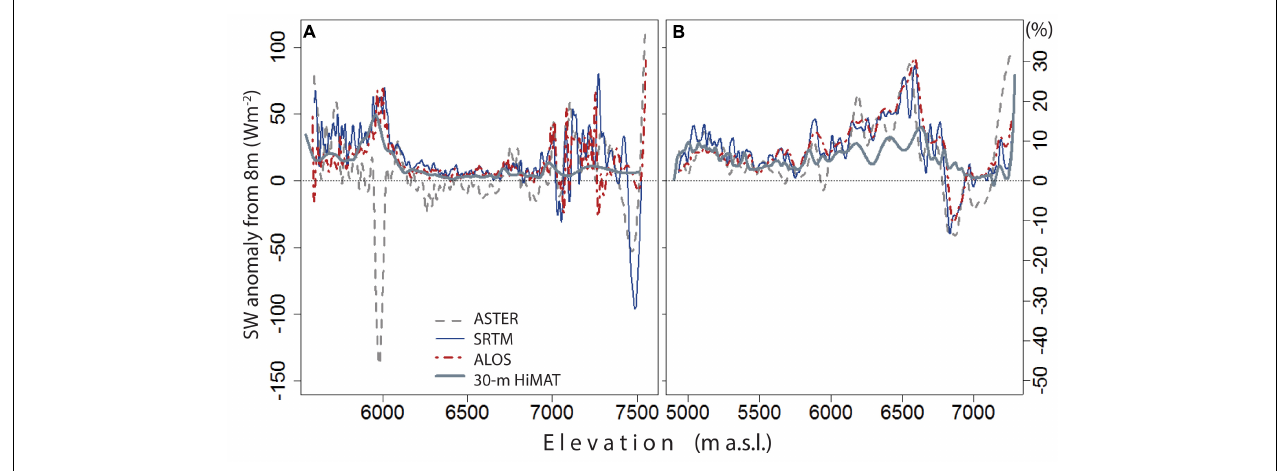
FIGURE 7 | Modeled shortwave bias, relative to the 8-m HiMAT DEM, for each 30-m DEM product (i.e., ASTER GDEM, SRTM, ALOS, and coarsened 30-m HiMAT DEM) on the East Rongbuk Glacier (A) and the Lumsamba Glacier (B) on March 21. An average daily overestimation of ∼ 50–60 W m - 2 ( ∼ 20%) of incident SW radiation is common across many elevations when resolution is coarsened to 30-m, with some glaciers exhibiting average biases upward of 90 W m - 2 ( ∼ 30%). Although the SW bias is mostly similar between DEM products, bias values from ASTER can vary drastically at some glacier elevations (A) , however, ASTER is often more consistent across all 10 glaciers, similar to B